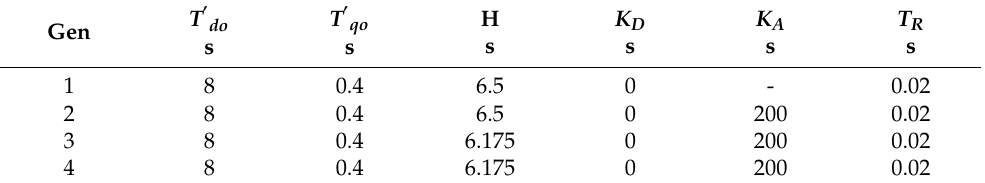
Table A3. Nominal parameters of synchronous generators of two-zone